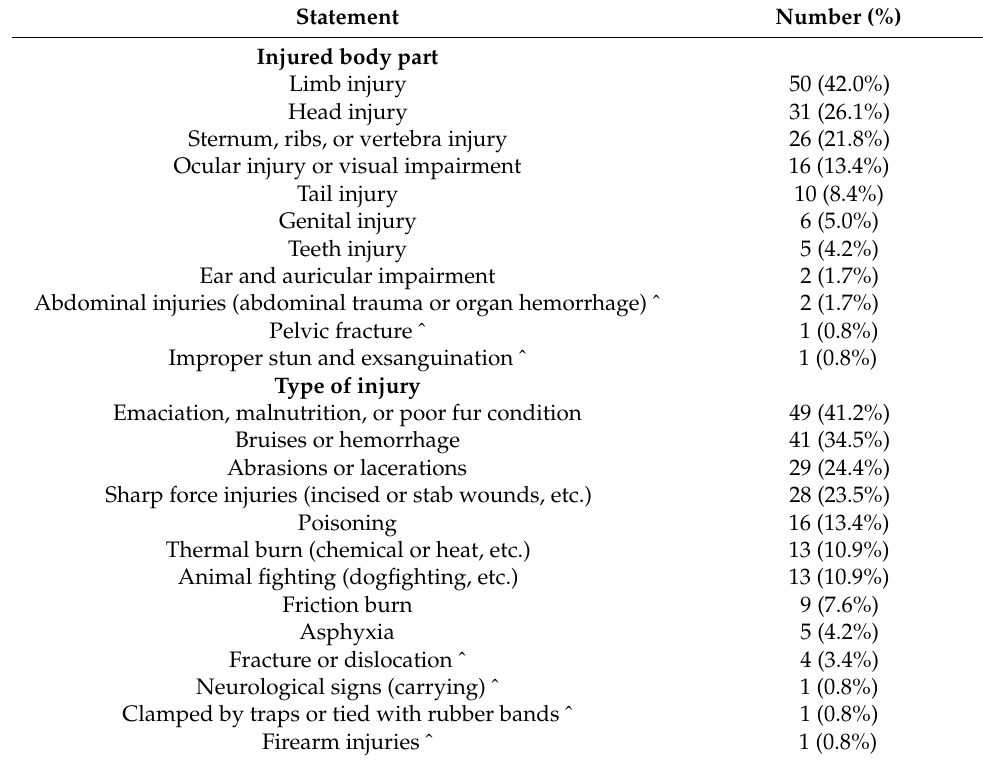
on these data. Table 13. The injured body part and type of injury caused by physical abuse. Multiple choices were allowed for these questions. These were open-ended questions, and the respondents could add options